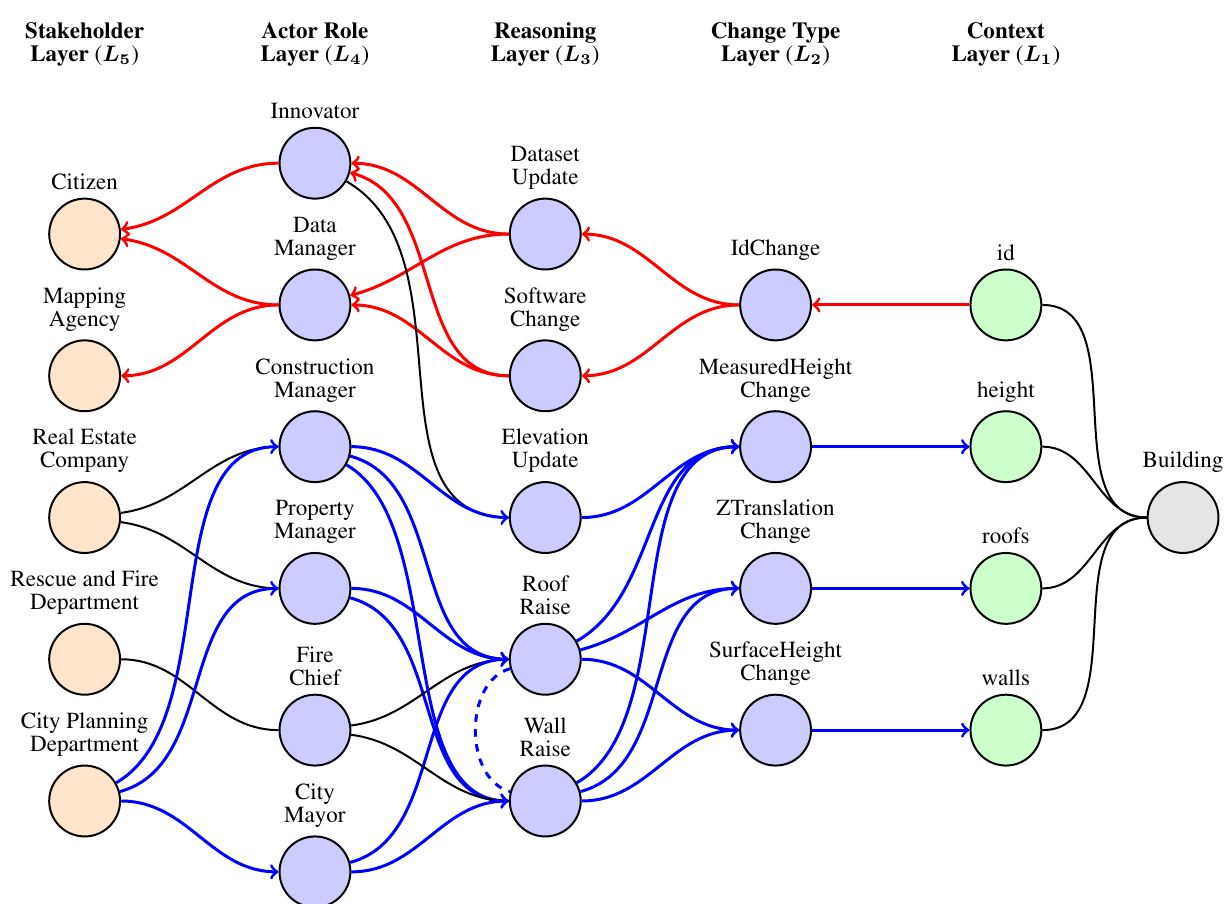
Figure 5. An example of a two-way Path-tracing Semantic Network (PSN) used to model and analyse changes, stakeholders and their relations. A forward and backward path-tracing are shown in red and blue